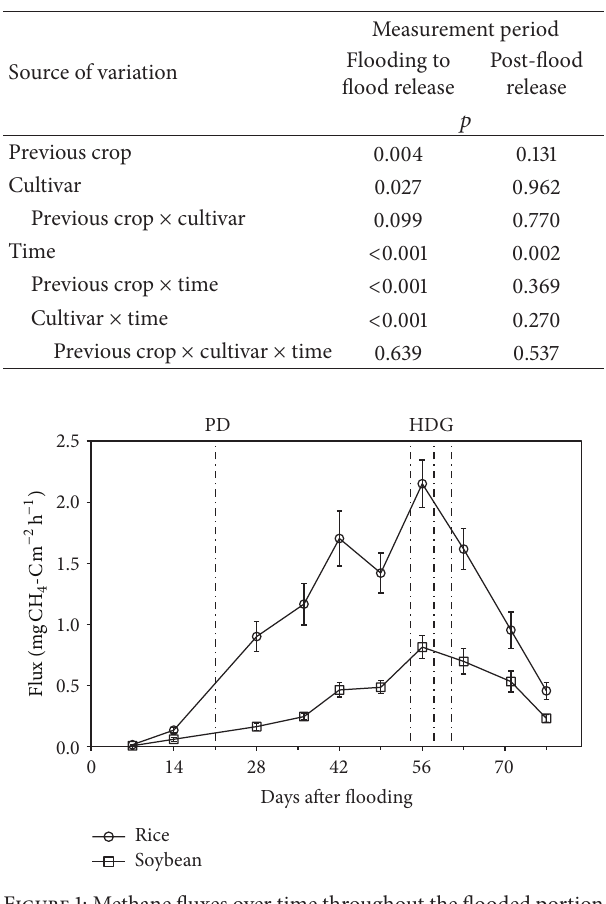
Table 2: Analysis of variance summary of the effects of previous crop, cultivar, time, and their interaction on methane (CH 4 ) fluxes fromfloodingtofloodreleaseandfollowingfloodreleasefromaclay soil during the 2013 growing season at the Northeast Research and Extension Center in Keiser, Arkansas.